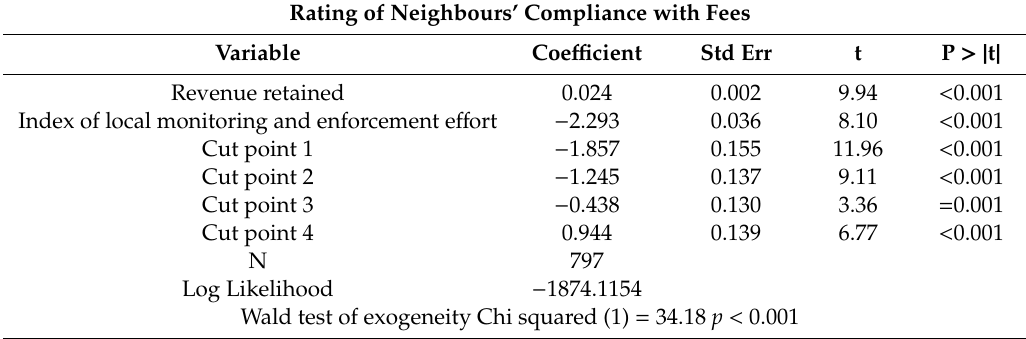
Table 2. Ordered logistic regression of compliance (measured as reported neighbours’ compliance) as a function of the local monitoring and compliance e ff ort index and proportion of fees retained